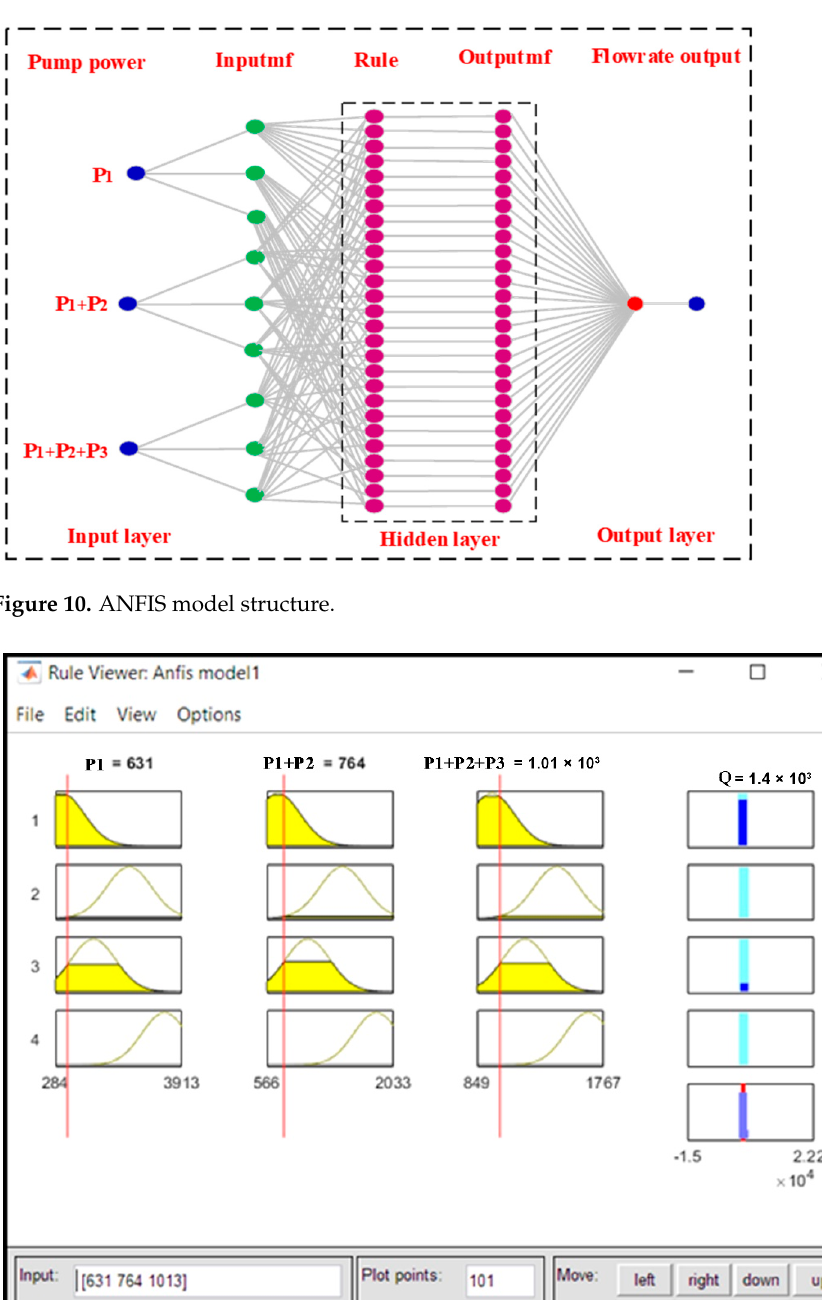
Figure 9. Anfis surface output.